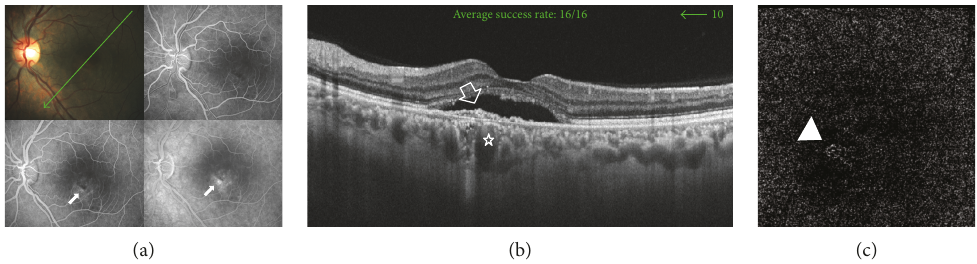
Figure 4: (a) The colored photo and FFA of the left eye of a 35-year-old male with chronic CSCR of approximately 2-year duration. The macular area shows shallow neurosensory detachment. Corresponding FFA shows hyper fl uorescent leaking points (arrows). (b) The radial scan SS-OCT image of the same eye demonstrates subfoveal neurosensory detachment with subretinal hyperre fl ective deposits. A subfoveal fl at irregular PED associated with sub-RPE hyperre fl ective material is seen (open arrow). Subfoveal choroidal thickness is 400 μ . Note the engorged choroidal vessels beneath the PED (star). (c) The en face SS-OCTA image of the same eye at the level of the outer retina in a 4.5mm × 4.5mm fi eld. Note the characteristic hyperintense signal of vascular fl ow within tiny interlacing capillaries in the foveal area (arrow